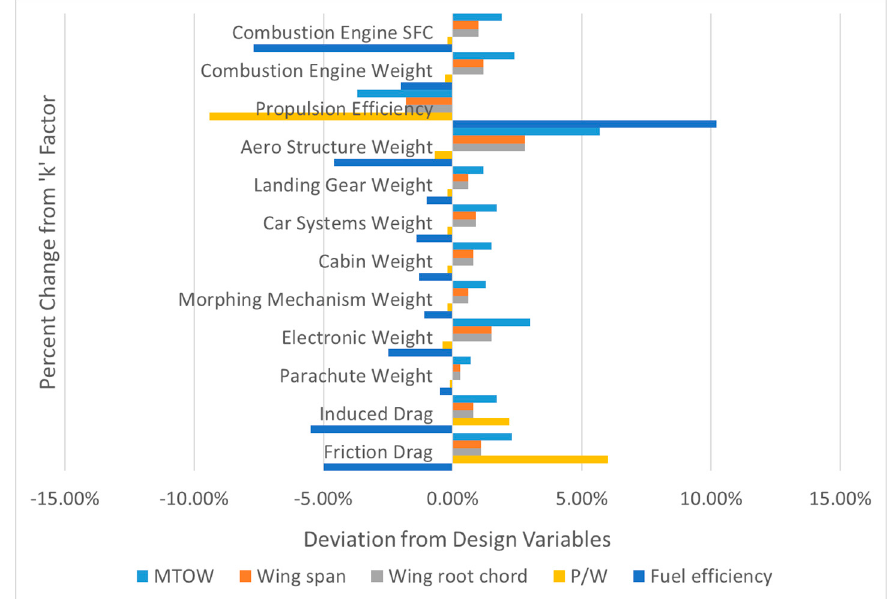
Figure 15. K-factor sensitivity analysis: deviation of design variables 2 for 10% increase of the k factor.